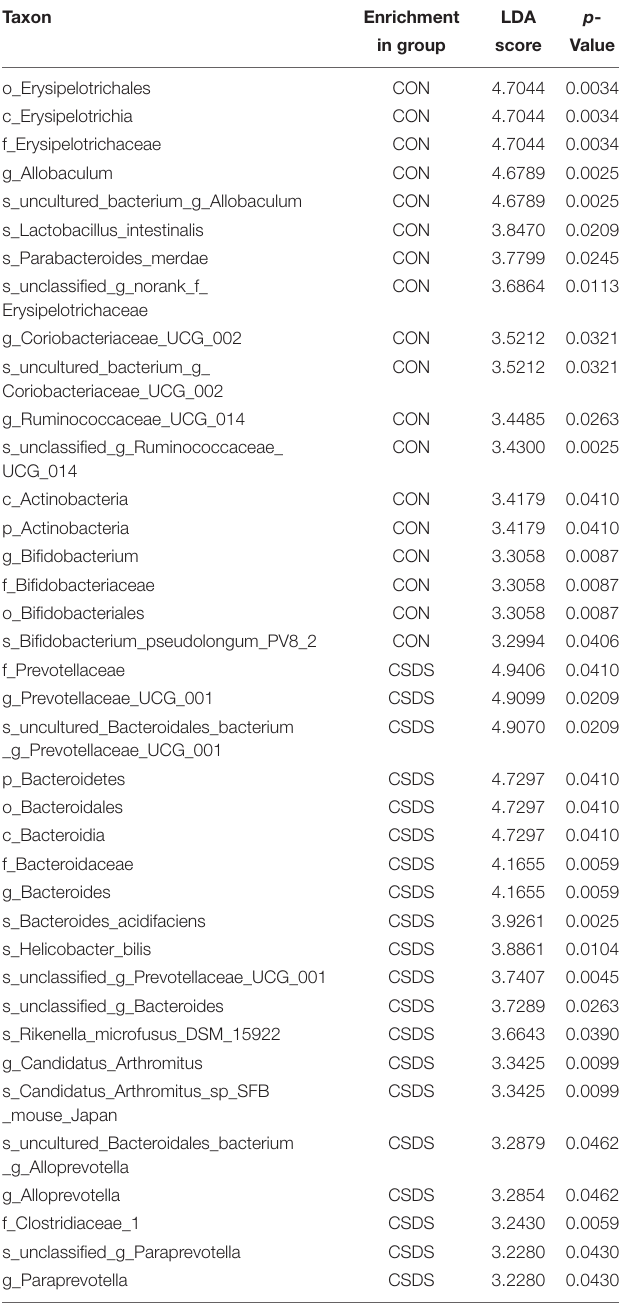
TABLE 1 | Differentially abundant taxonomy between the control and CSDS groups analyzed by LEfSe (from phylum to species levels). Taxon Enrichment